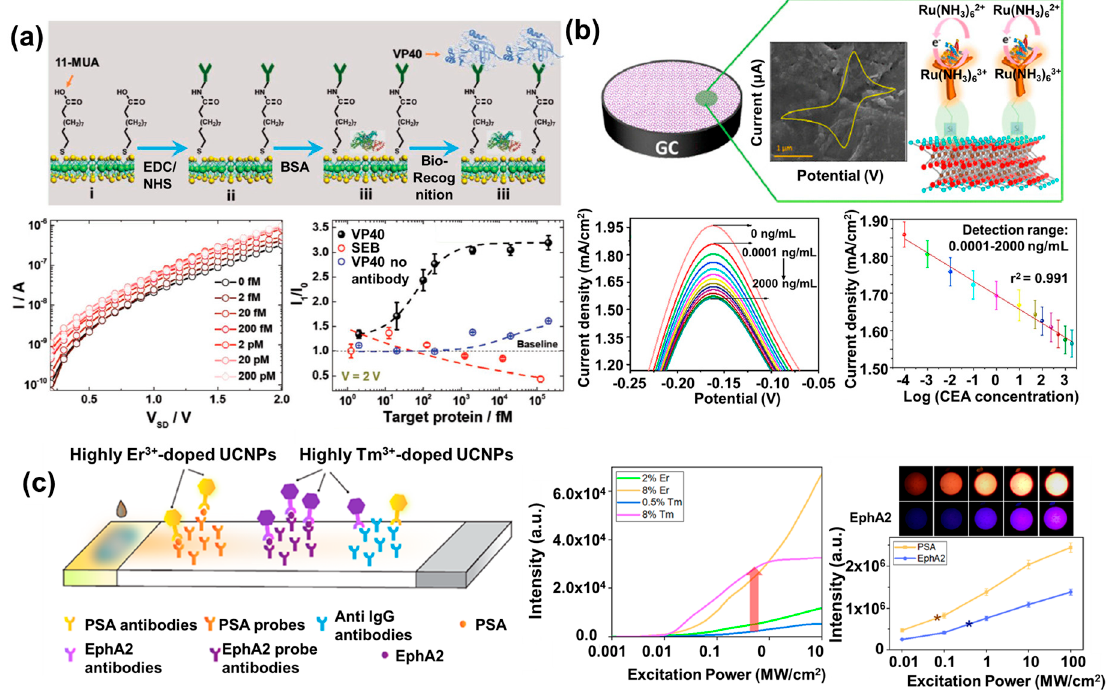
Figure 4. Biosensors developed based on novel nanomaterials. ( a ) Electrochemical biosensor composed of high-quality 2H-MoS 2 to detect the VP40 matrix protein from the Ebola virus, and I–V characteristics for detecting the antigen–antibody reaction (reproduced with permission from Reference [74], published by John Wiley and Sons, 2019). ( b ) A schematic of the electrochemical biosensor composed of Ti 3 C 2 –MXene (few-atom-thick layer of transition metal carbides, nitrides, or carbonitrides) for sensitive and reproducible carcinoembryonic antigen (CEA) detection, and cyclic voltammogram obtained by using fabricated electrochemical biosensor for detection of di ff erent concentrations of target molecules (reproduced with permission from Reference [75], published by Elsevier, 2018). ( c ) A schematic of the LFA biosensor based on highly doped upconverting NPs (UCNPs) to detect PSA and type-A receptor 2 (EphA2) with high sensitivity and selectivity, and photo and fluorescence intensities of testing areas of di ff erent concentrations of PSA and EphA2 (reproduced with permission from Reference [77], published by American Chemical Society, 2018).